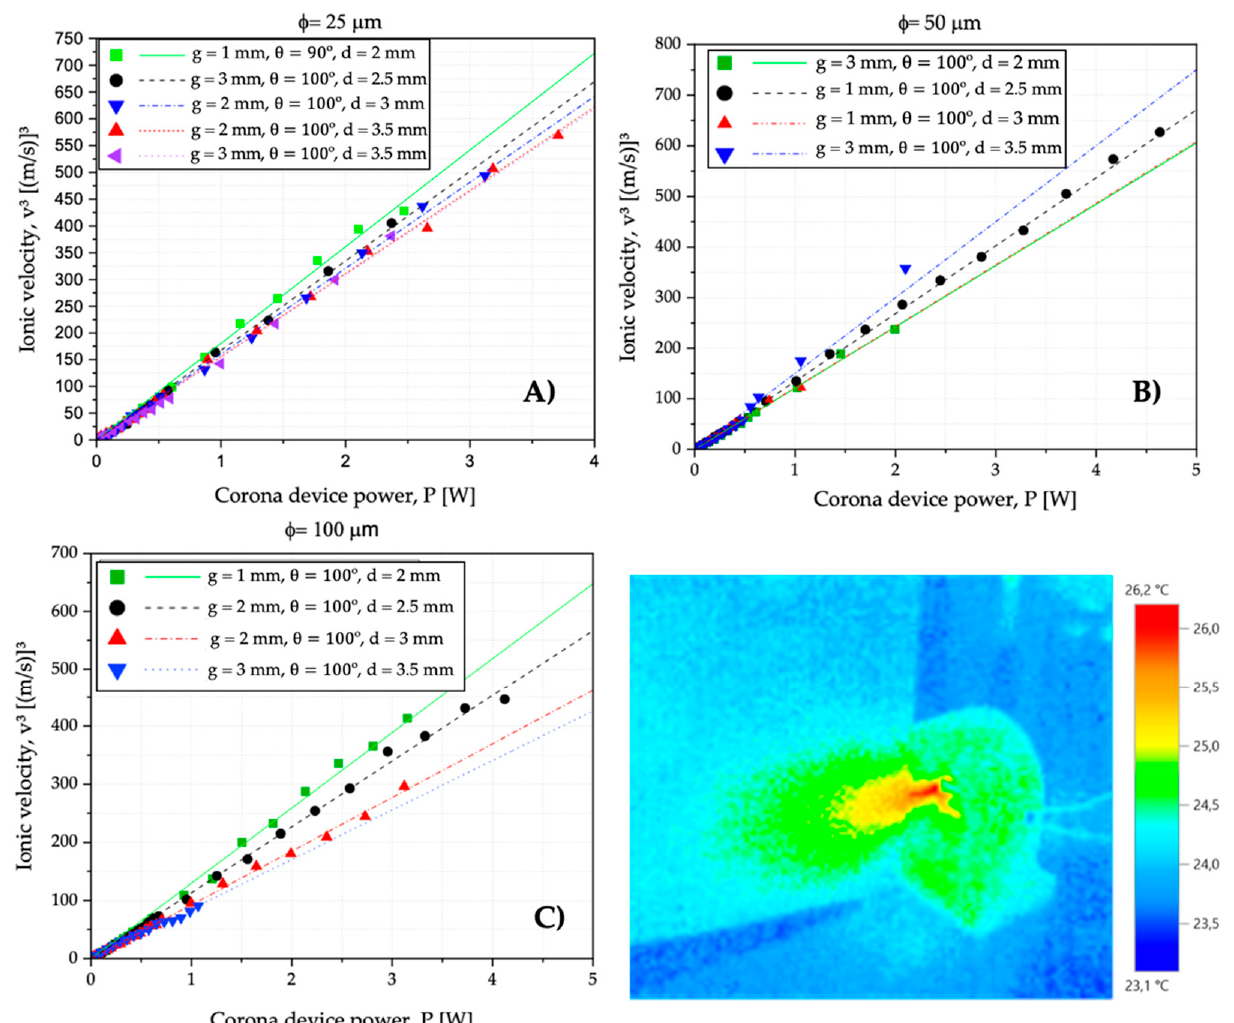
Figure 10. Dynamic behavior of the airflow with diverse diameters ( A ) 25, ( B ) 50, and ( C ) 100 μ m considering the best electrode arrangements and a thermal image of the device with the aerodynamic plume.